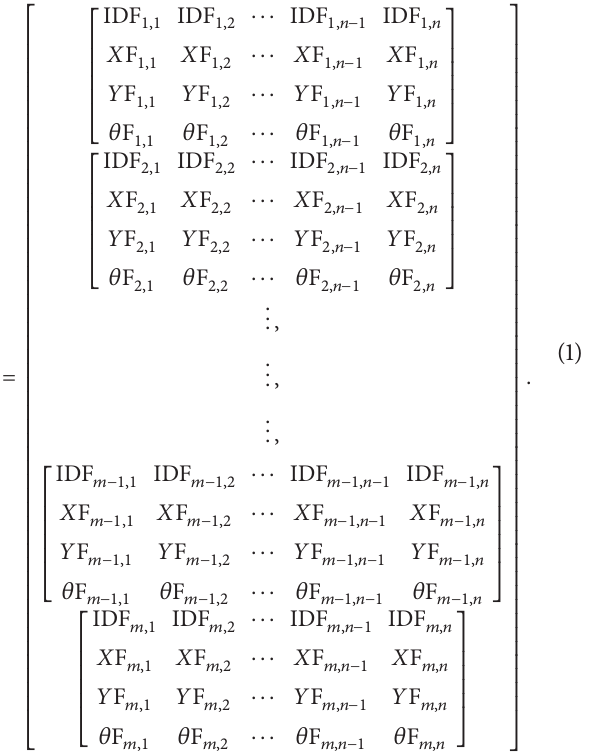
path generation for each robot. A new mapping method is solve the multifloor mapping problem. In this method the landmarks ID and related information are stored in a relative map that is used with a navigation program to reach the required destination based on the planning path.